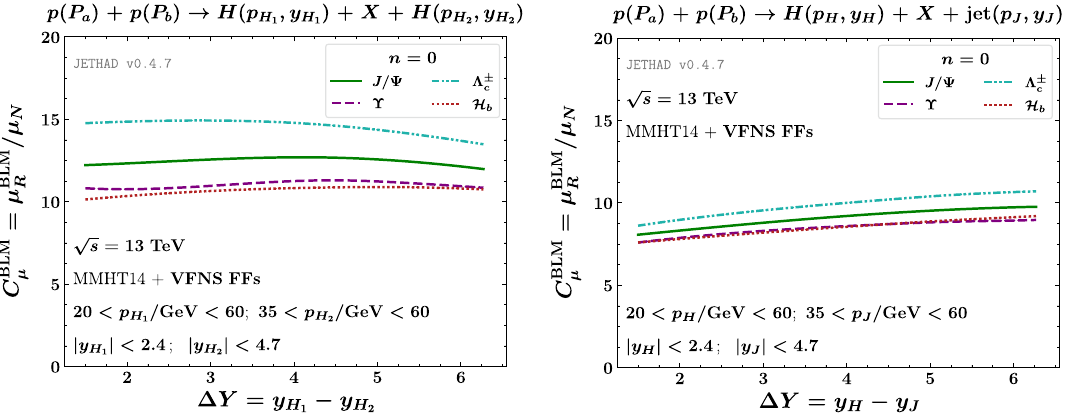
where other heavy-flavored hadron species are detected: (cid:8) c baryons and H b hadrons. Text boxes inside panels show transverse-momentum and rapidity